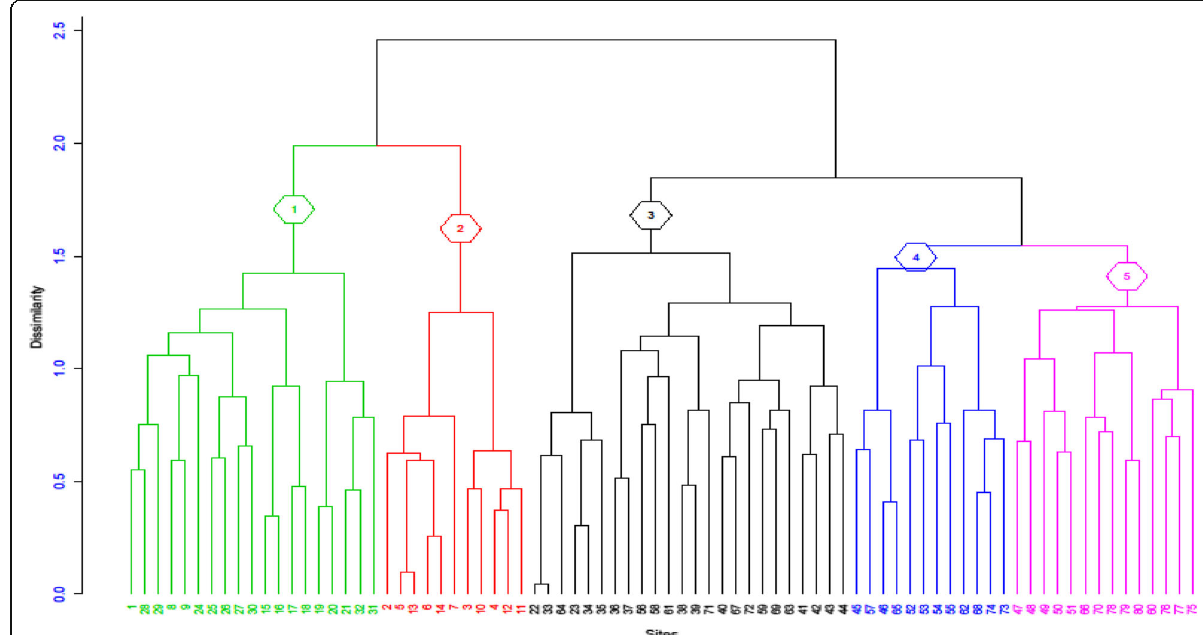
Fig. 3 Dendrogram showing plant community types in the Hirmi